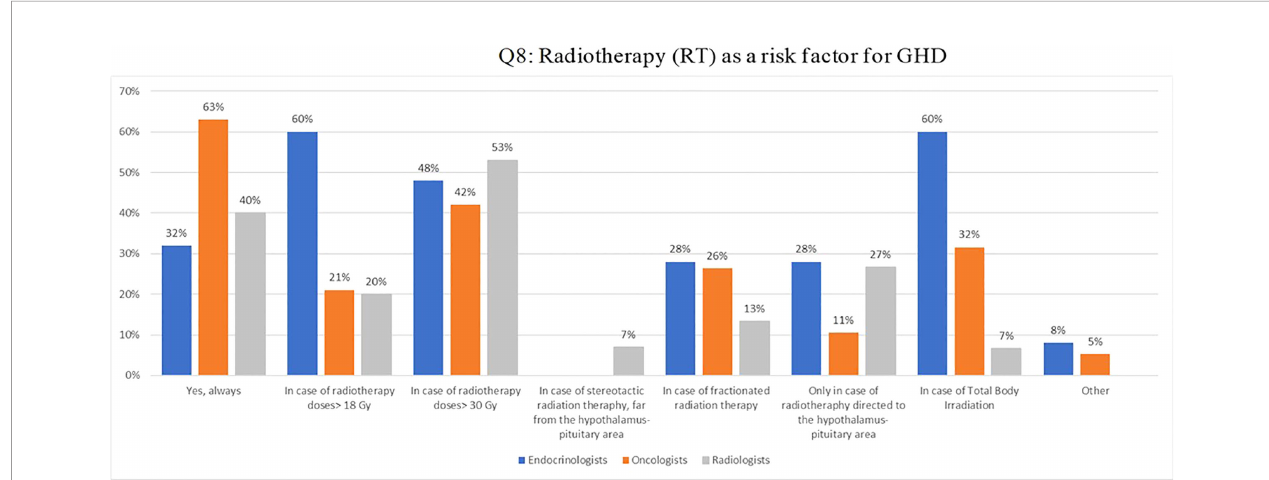
FIGURE 2 | Q8: Radiotherapy (RT) as a risk factor for